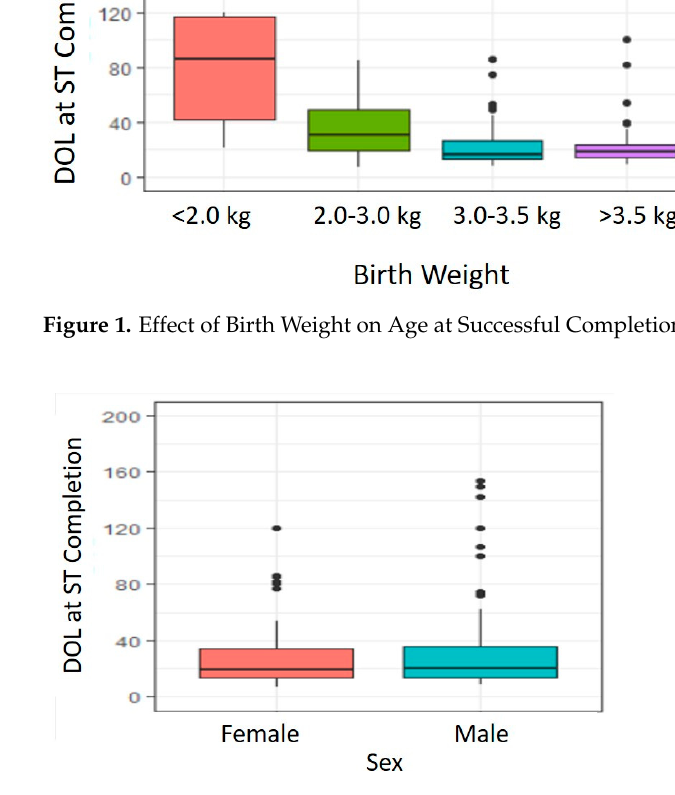
Figure 2. Effect of Sex on Age at Successful Completion of Sweat Chloride Testing.